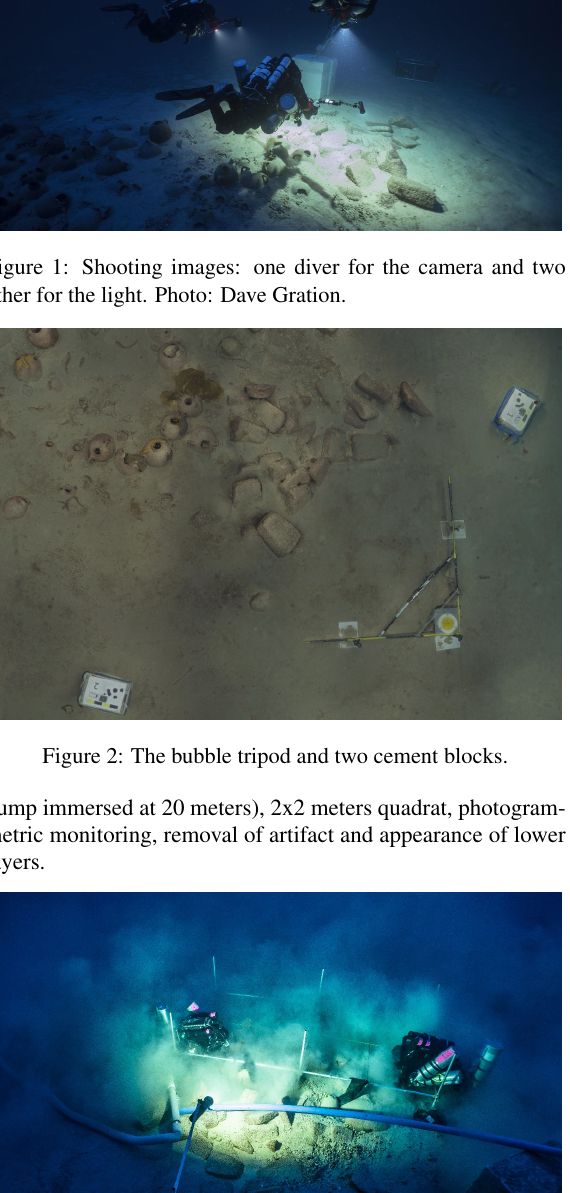
Figure 3: Excavation on Xlendi by divers with rebreather at 110 meters depth. Photo: Dave